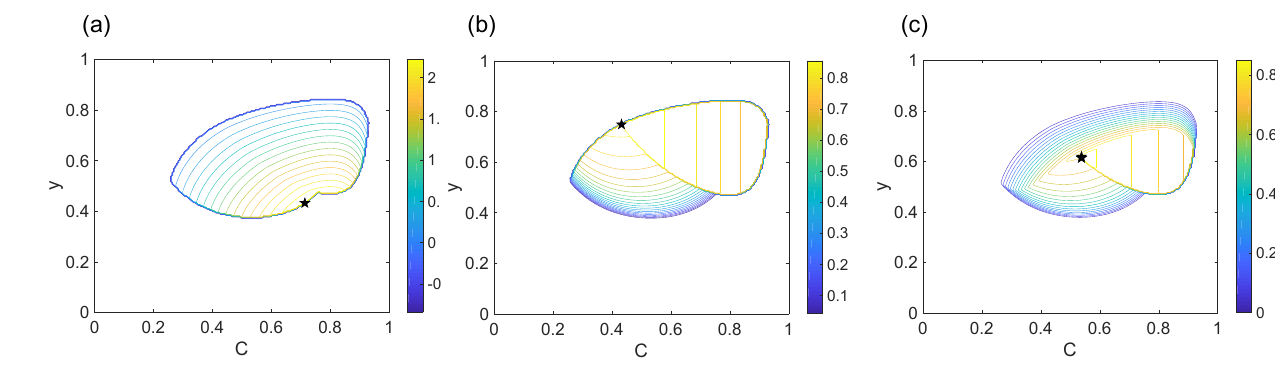
Figure 1. Resilience metrics for a specific setting (a g – w combination) inside the sustainable region in the policy space (i.e., C – y plane): (a) R PPC contours; (b) R stability contours; and (c) R system contours. The black star in panels (a) , (b) , and (c) indicates the policy with the highest R PPC , R stability , and R system ,